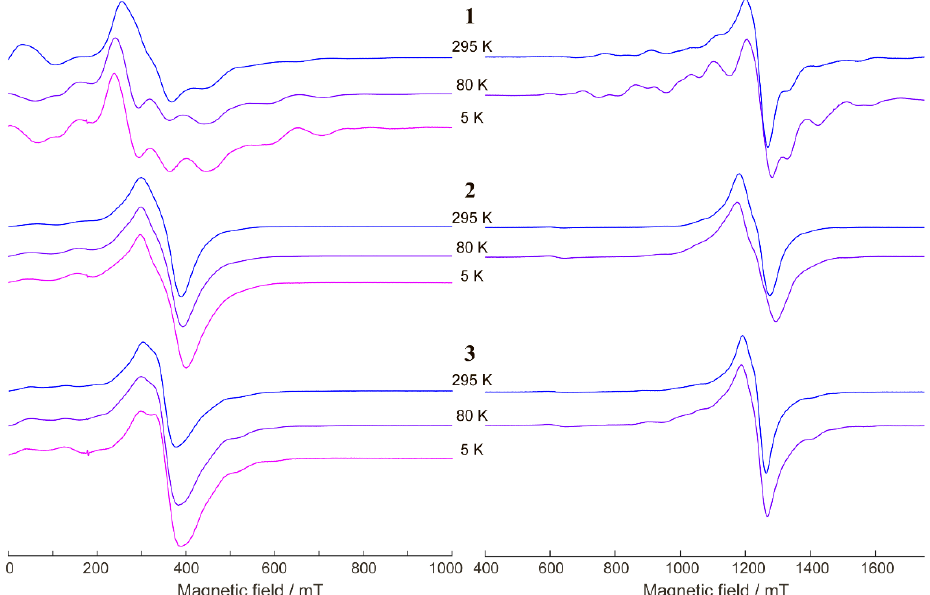
Figure 8. X-band (left) and Q-band (right) EPR spectra of 1 – 3 (as indicated) at T = 295, 80, and 5 K. ≈ 9.75 GHz at the X-band and ν ≈ 34.20 GHz at the Q-band. ν mw mw The zero-field splitting values D and E for 1 can be estimated simultaneously from the simulation of X/Q-band spectra (see Supplementary Materials). It was found that D was around ~0.08 cm − 1 and E / D ~ 0.1–0.15. For the two other compounds, 2 and 3 , the